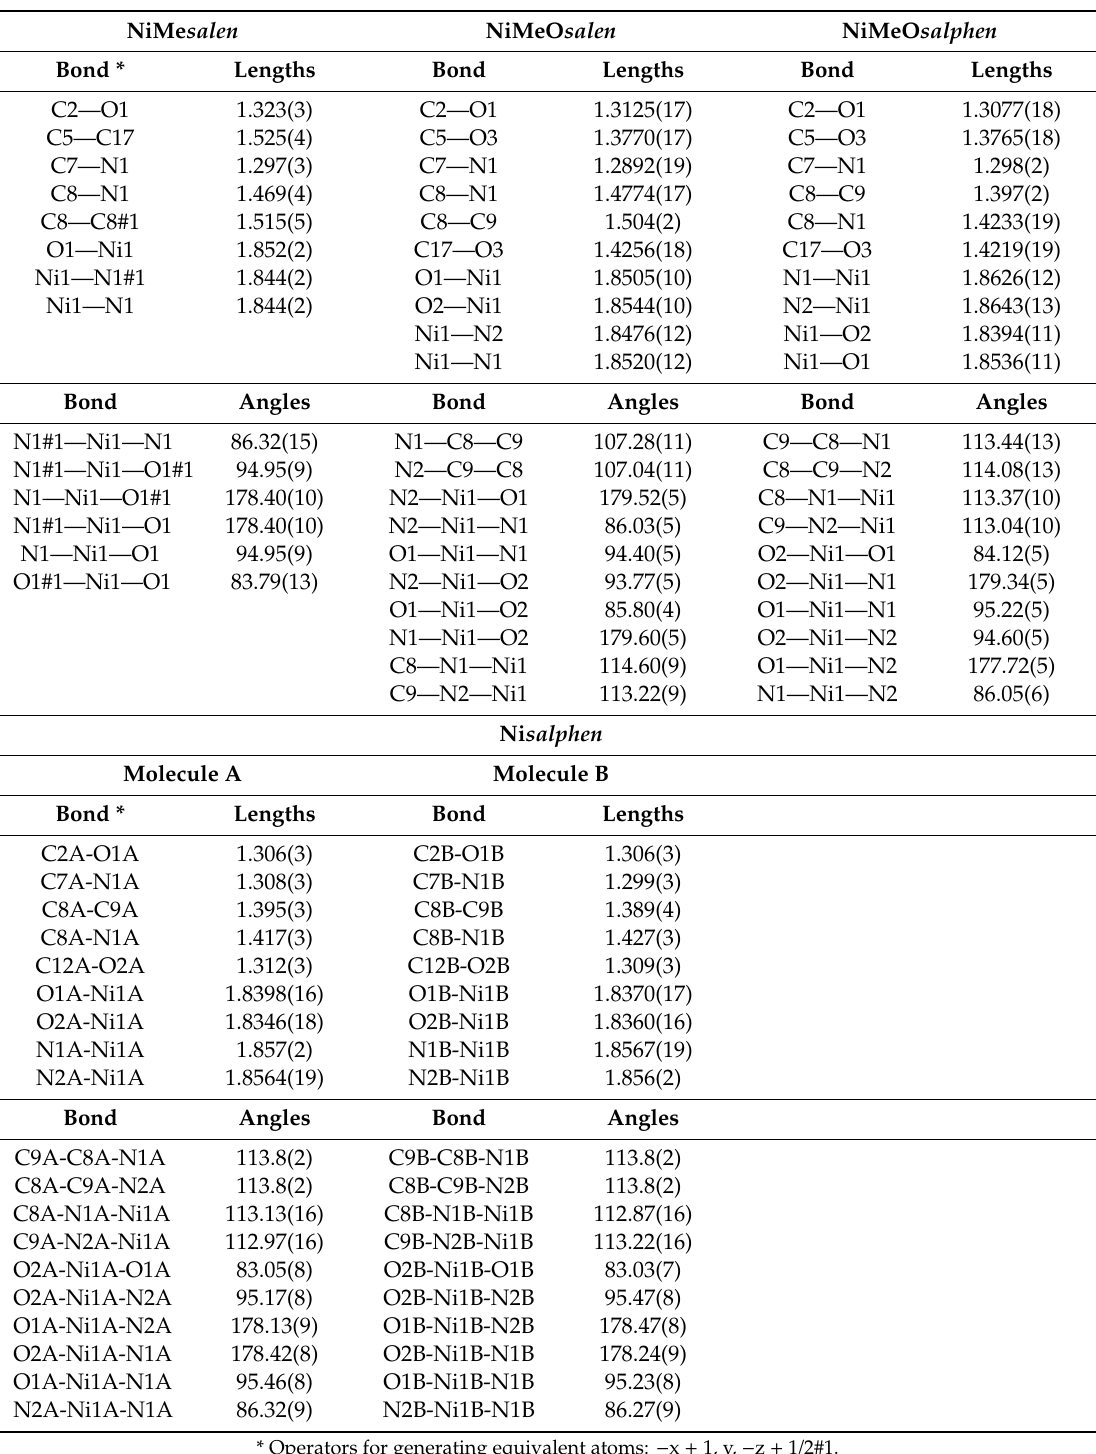
Table3. Selected bond lengths (Å)and angles ( ◦ ) for compounds NiMe salen, NiMeO salen , NiMeO salphen , and Ni